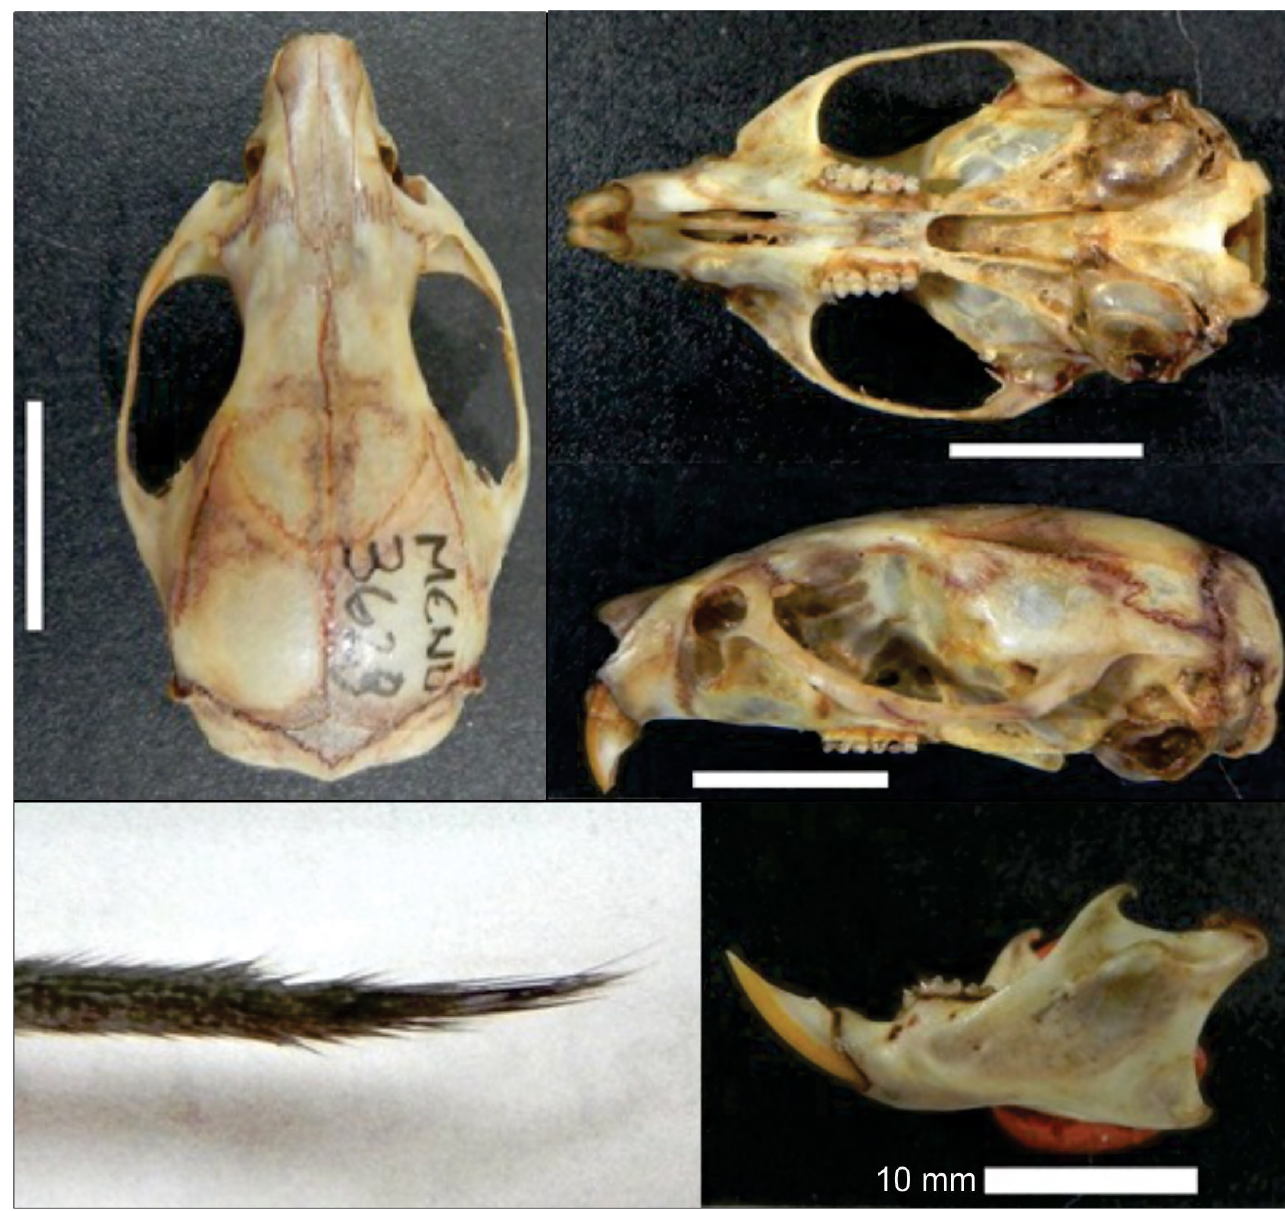
Figure 3. Abrawayaomys ruschii adult female MCNU3629 collected in Chapecó, Santa Catarina state, southern Brazil. Dorsal, ventral, and lateral views of the skull. On the bottom, left photo, the brush of hairs of the tail tip. On the bottom right, lateral view of the mandible. The scale bar (in white) in each photo represents 10